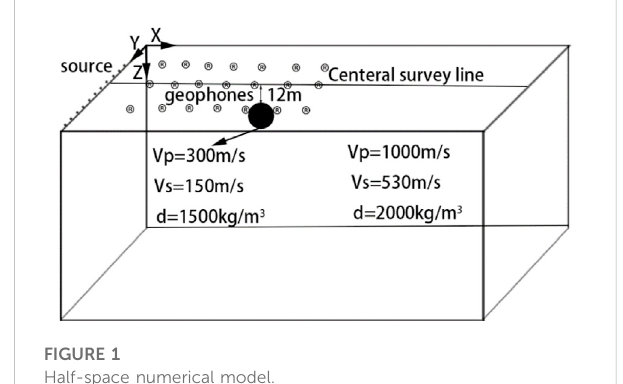
FIGURE 1 Half-space numerical model.